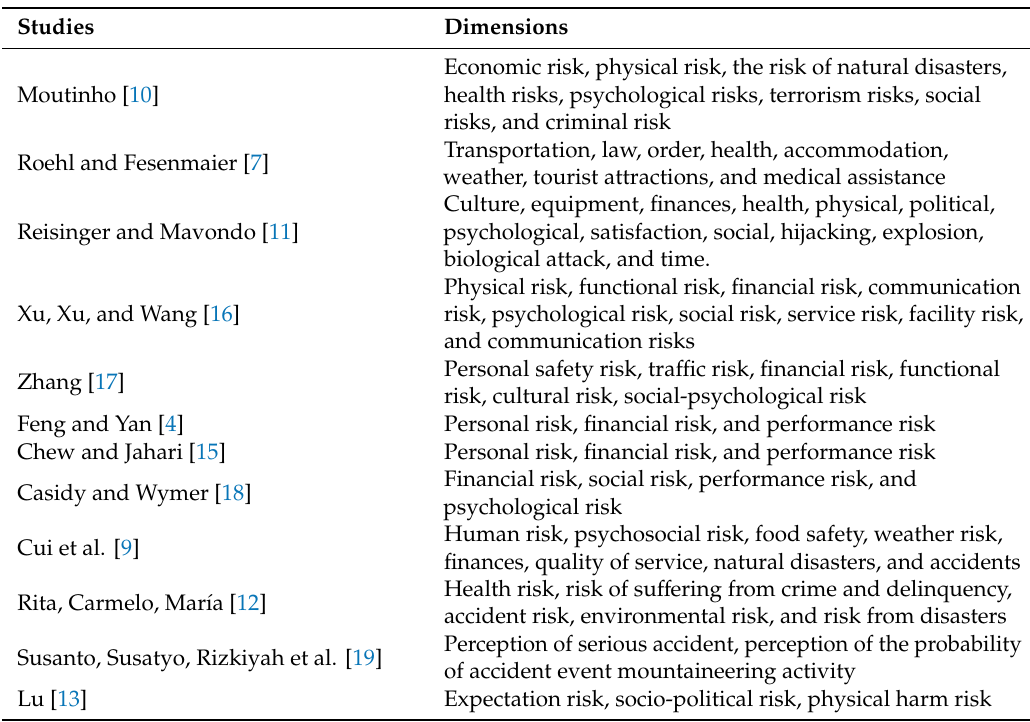
Table 1. Dimensions of travel